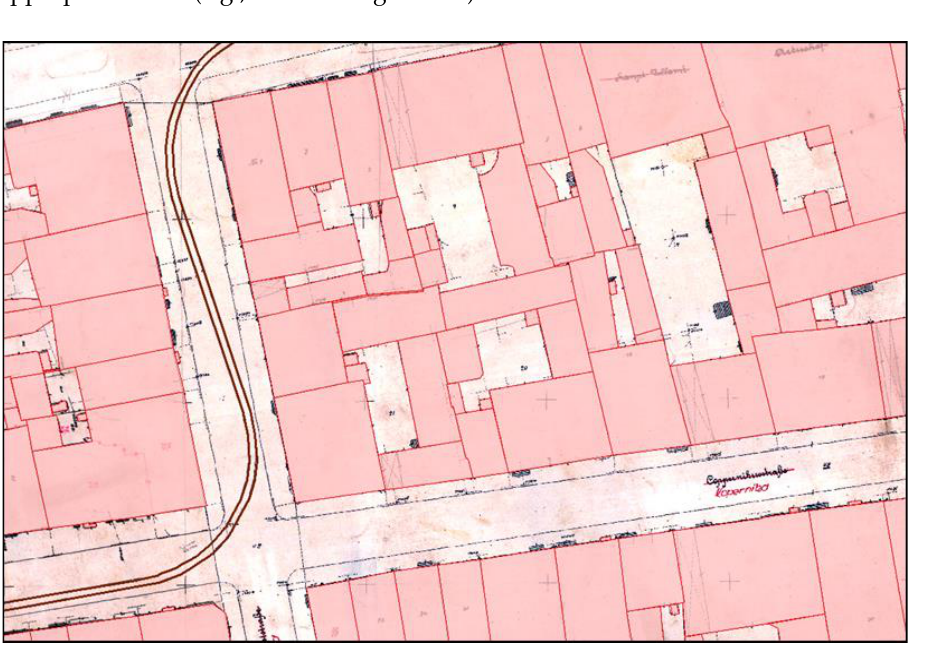
Figure 7. A fragment of the cadastral map of Toruń showing vectorised plot boundaries (red). Source: own work based on Gemarkungskarte der Stadt Thorn, Blätter 43, 44, 45, State Archives in Toruń.